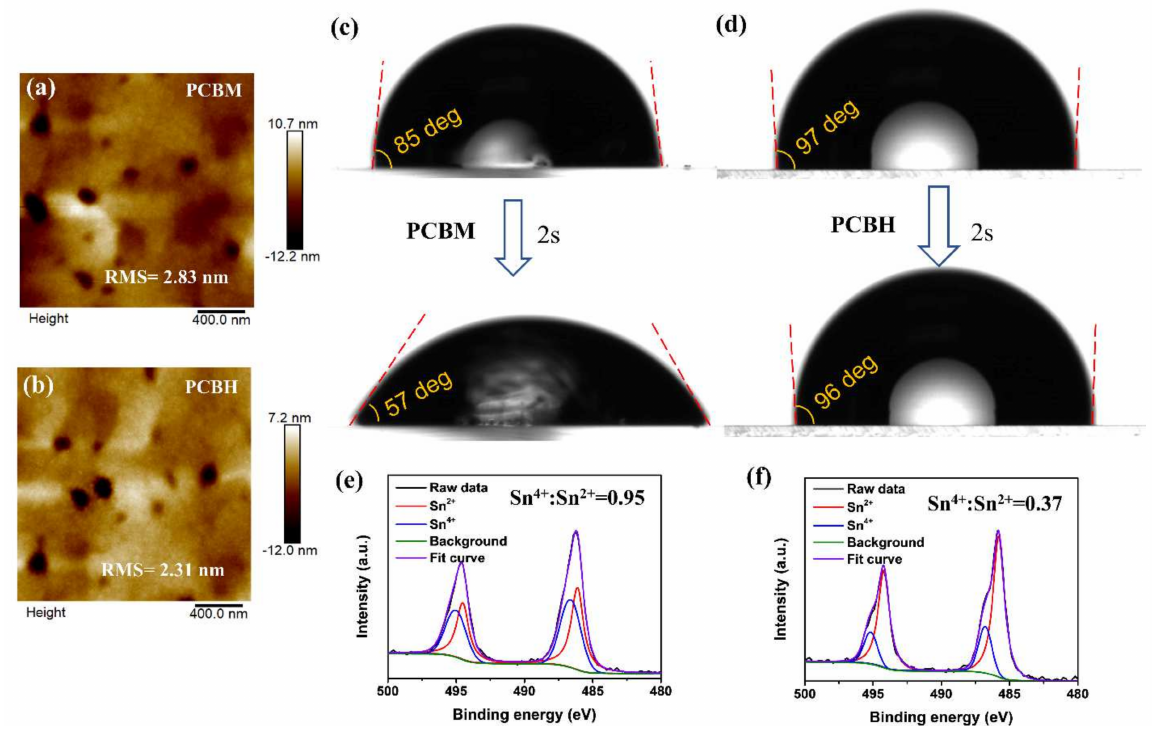
Figure 4. AFM images of the different fullerene films on perovskite substrates: ( a ) PCBM, ( b ) PCBH. The evolution of the contact angle measurement for the ( c ) PCBM and ( d ) PCBH. XPS Sn 3d spectra of the perovskite films with the upper layer of ( e ) PCBM and ( f ) PCBH removed. Atomic ratio of the Sn 4+ /Sn 2+ derived from the XPS Sn 3d spectra.